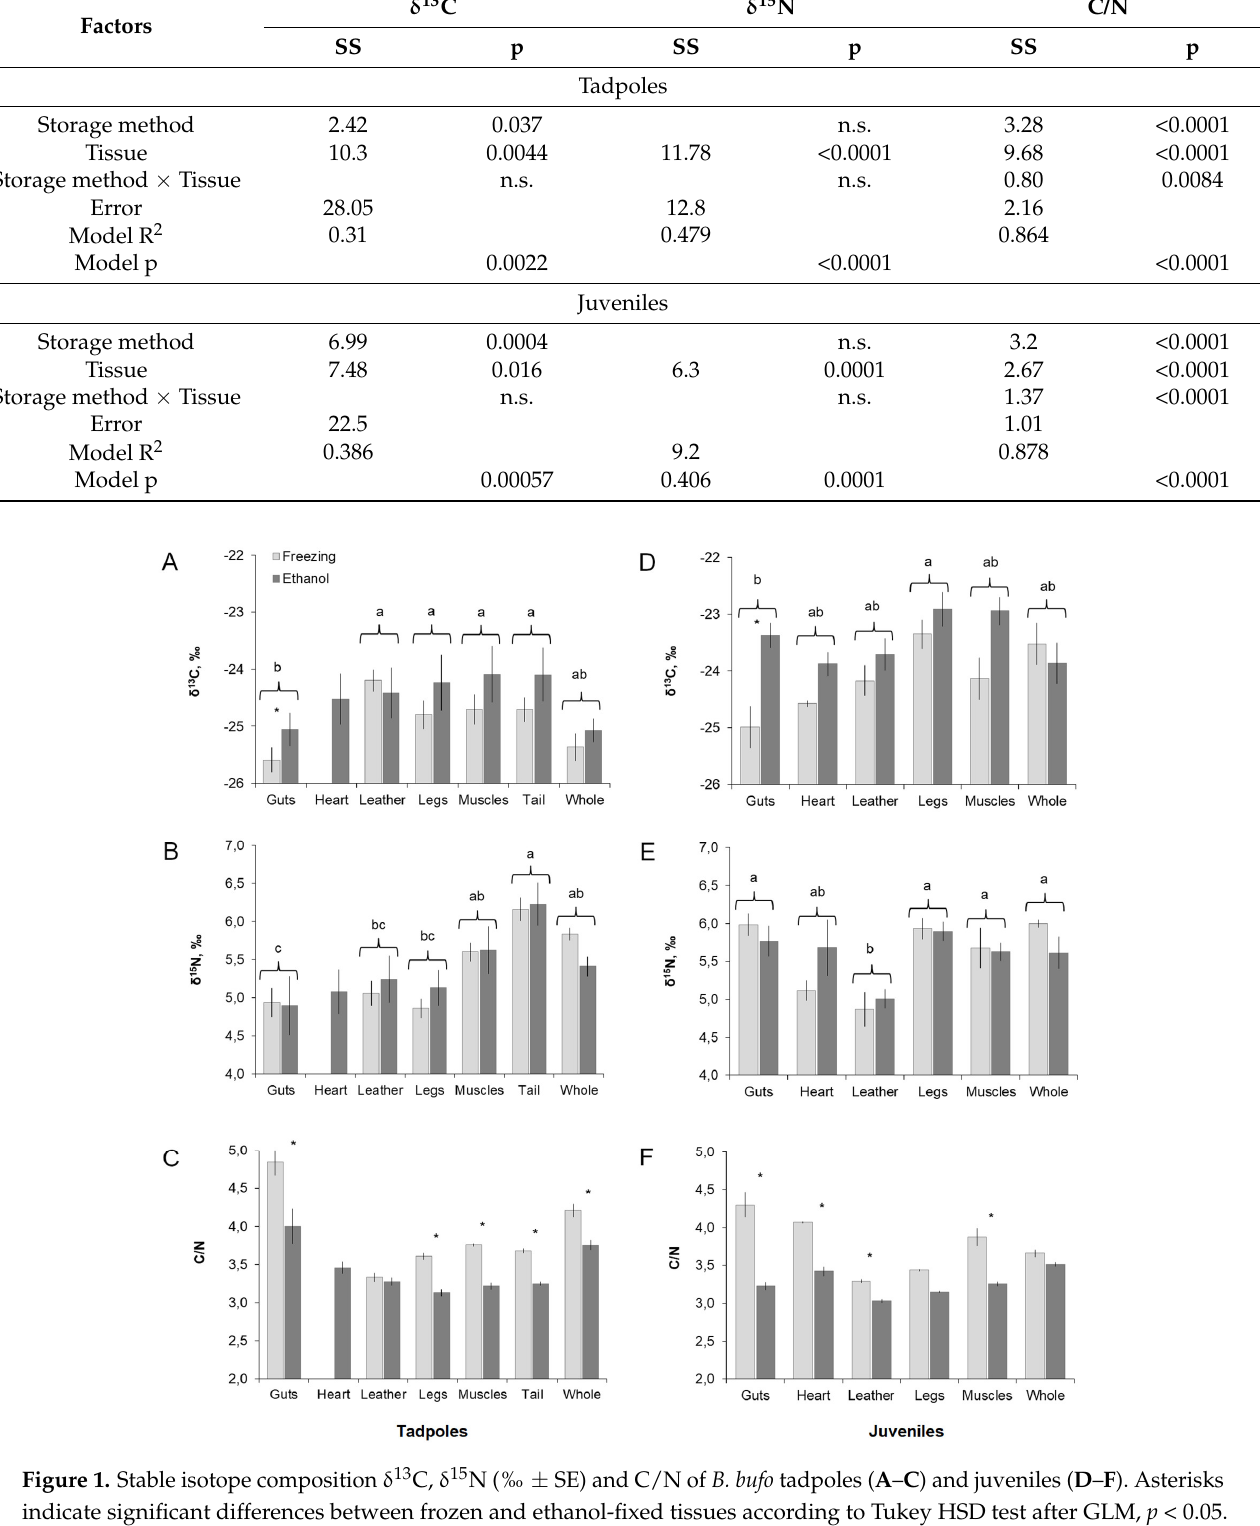
Table 1. Results of GLM (forward stepwise selection of factors) for mean δ 13 C, δ 15 N and C/N values of Bufo bufo tadpoles and juveniles. Heart values were removed from the “tadpole” dataset. “SS”—sums of the squares, “p”—probability levels, “Error” refers to the total unexplained variance remaining in the model. “n.s.” indicates lack of significant results ( p > 0.05).